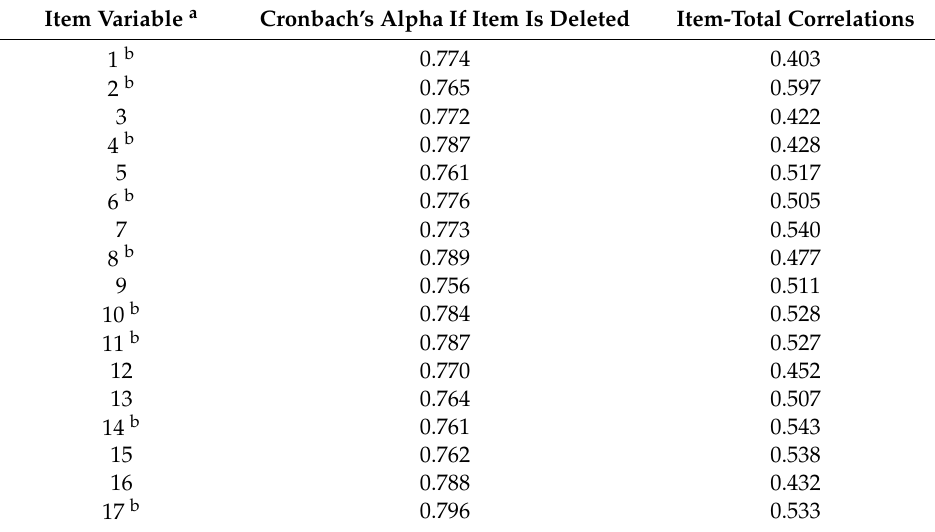
Table A3. Evaluation of reliability and internal consistency of the total IIFAS-S score ( n = 118).